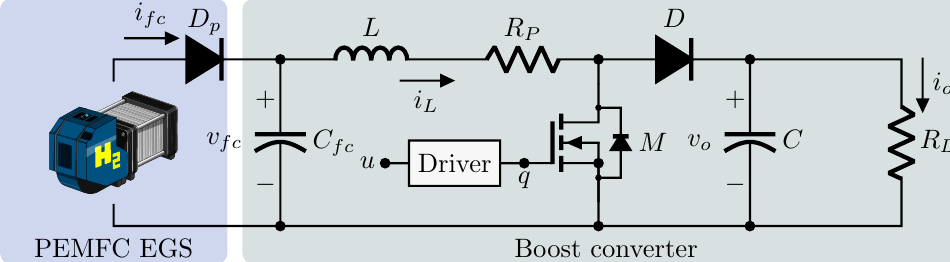
Figure 1. Fuel cell system composed of a PEMFC EGS feeding a purely resistive load through a DC–DC boost converter as the